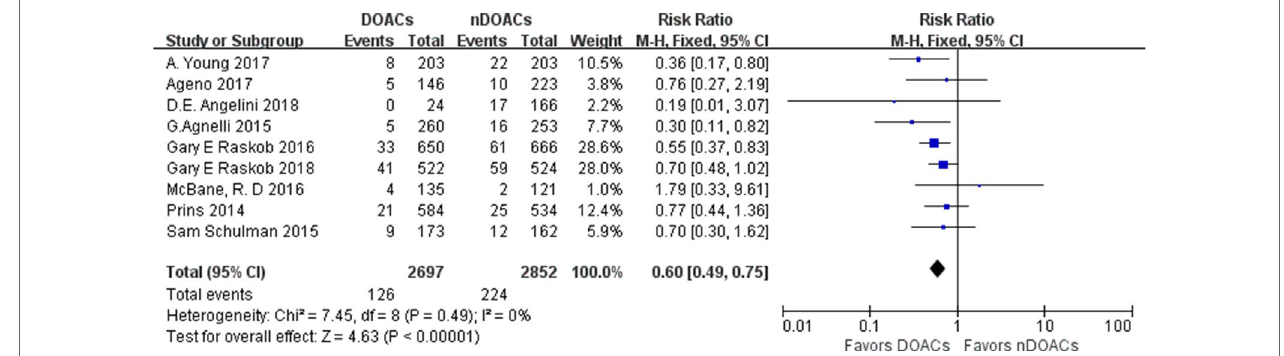
FIGURE 2 | Recurrence venous thromboembolism (VTE) forest plot.